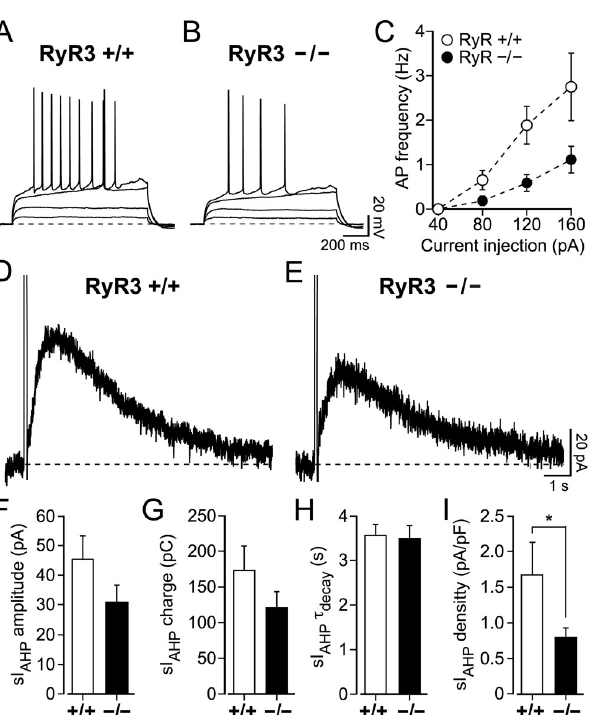
Fig 4. Lack of type 3 ryanodine receptor (RyR3) affects the firing properties and sI AHP current density in mouse CA1 pyramidal neurons. ( A-B) action potentials were induced by current injections from 40 pA to 160 pA (in 40 pA step-increments) for 1 s in RyR3 +/+ and RyR3 − / − CA1 pyramidal neurons. The membrane resting potential was -68 mV (A) and -69 mV (B). ( C) Action potential frequency was higher in RyR3 +/+ compared to RyR3 − / − CA1 pyramidal neurons at the same stimulation strength (P = 0.004, two-way ANOVA with Bonferroni’s test). At 40 pA action potentials could not be elicited in either RyR3 +/+ or RyR3 − / − CA1 pyramidal neurons. The action potential frequency did not differ significantly (P = 0.5) for current injections at 80 pA for RyR3 +/+ (0.7 ± 0.2 Hz, n = 32) and RyR3 − / − (0.2 ± 0.1 Hz, n = 37). However, at higher current injections action potential frequencies were substantially different (120 pA: RyR3 +/+ = 1.9 ± 0.4 Hz, n = 27 vs RyR3 − / − = 1.1 ± 0.2 Hz, n = 34, P = 0.0003; and 160 pA RyR3 +/+ = 2.8 ± 0.8 Hz, n = 12 vs RyR3 − / − = .1 ± 0.3 Hz, n = 26, P = 0.001). ( D-E ) Representative sI AHP traces obtained from RyR3 +/+ and RyR3 − / − mouse CA1 pyramidal neurons. ( F-I ) Properties of the sI AHP recorded at steady-state in RyR3 +/+ and RyR3 − / − mice ~15 minutes after the onset of the recording. ( F ) No significant difference was observed for current amplitude (RyR3 +/+ = 42.5 ± 8.1 pA, n = 10 vs RyR3 − / − = 30.5 ± 6.1 pA, n = 7; P = 0.2). ( G) Similarly, there was no significant difference for sI AHP charge transfer (RyR3 +/+ = 172.9 ± 34.6 pC, n = 10 vs RyR3 − / − = 120.6 ± 22.8 pC, n = 7; P = 0.3) and ( H) the deactivation time constant of sI AHP (RyR3 +/+ = 3.6 ± 0.3 s, n = 10 vs RyR3 − / − = 3.5 ± 0.3 s, n = 7; P = 0.9). ( I) sI AHP current density was reduced in RyR3 -/- neurons (RyR3 − / − = 0.8 ± 0.1 pA/ pF, n = 7 vs RyR3 +/+ = 1.7 ± 0.5 pA/pF, n = 10; P = 0.03, Mann-Whitney